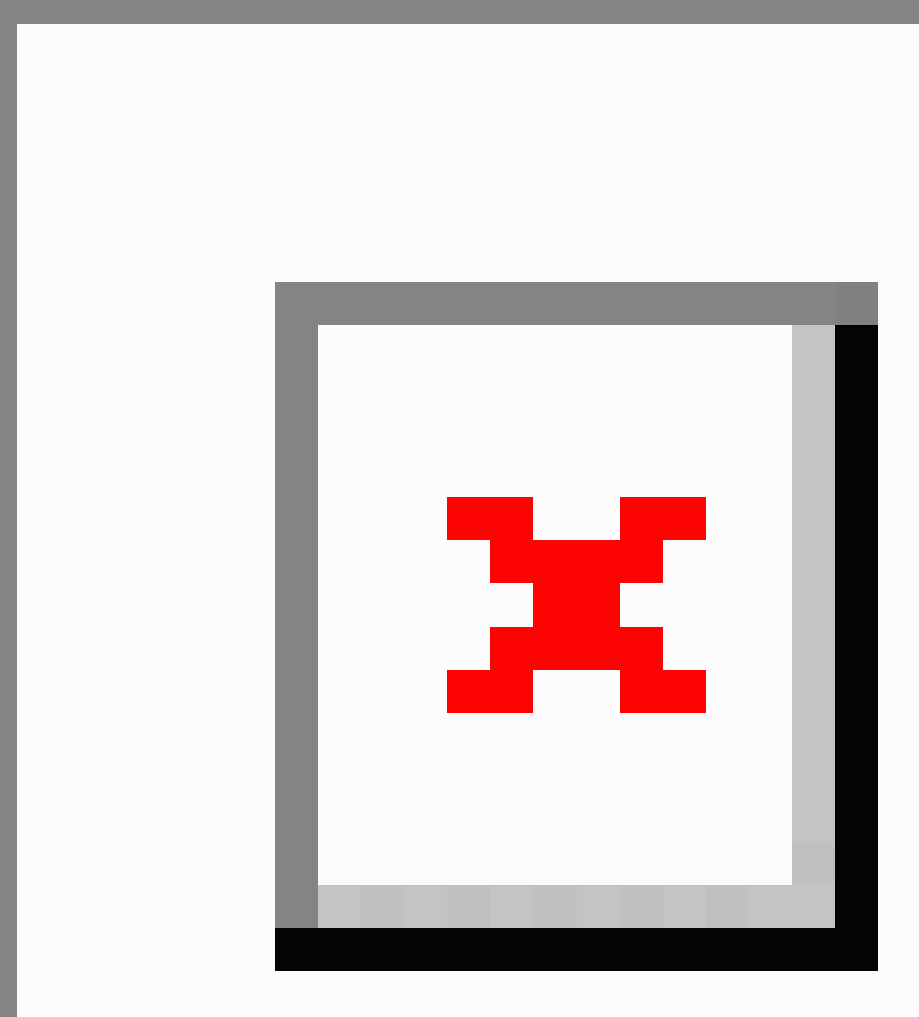
Figure 3. Six quitting strategies used in association with the DistractMe